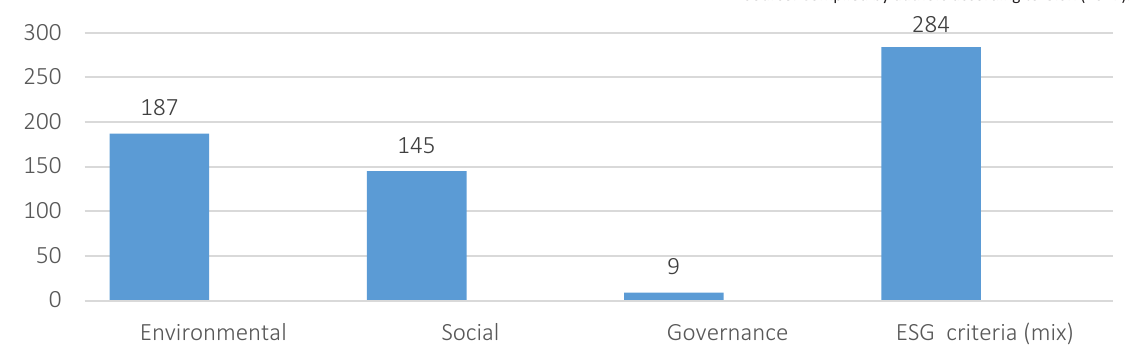
Figure 5. Criteria for the compilation of sustainability ratings in